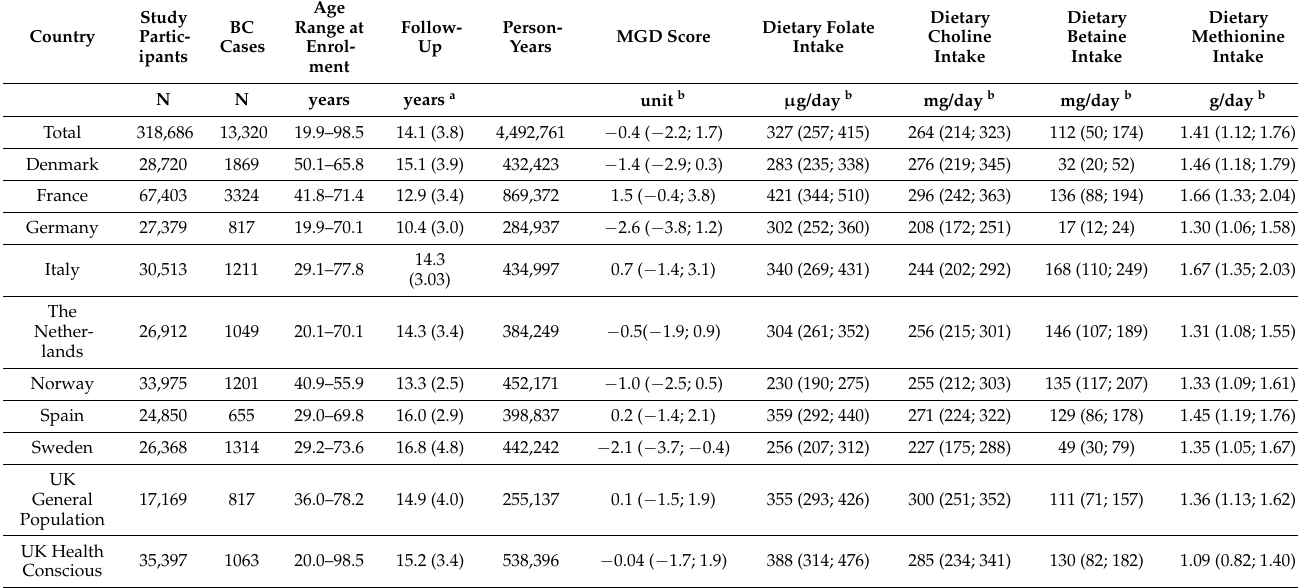
Table 1. General population characteristics and dietary methyl-group donor intake: malignant breast cancer cases of women in the European Investigation into cancer and nutrition (EPIC) cohort by